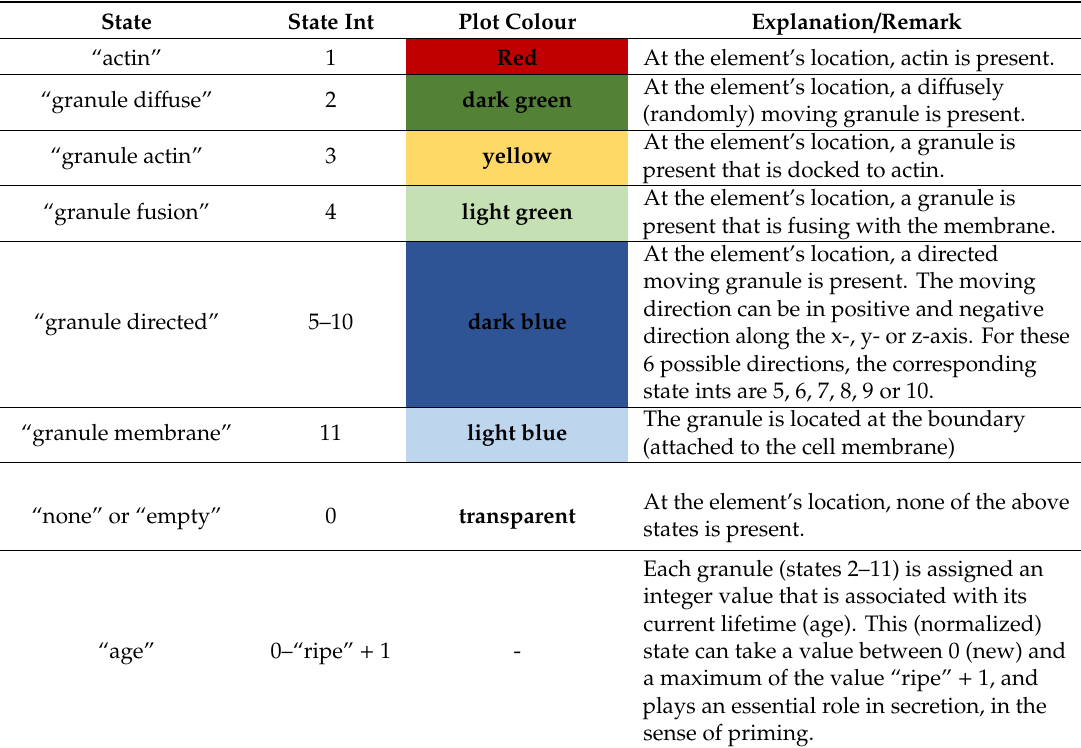
Table 1. Possible states and associated